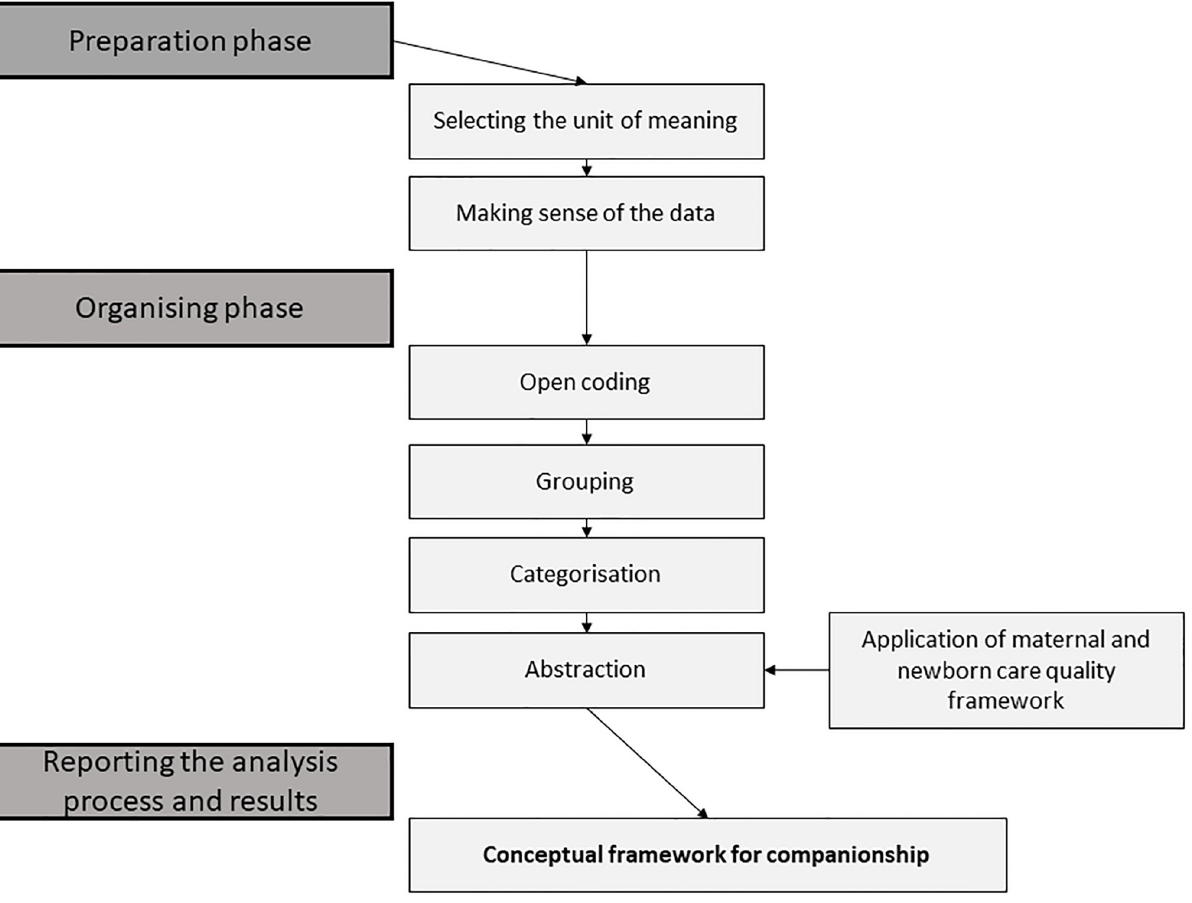
Fig 1. Preparation, organizing and reporting stages of content analysis. Adapted from Elo and Kyngas 31